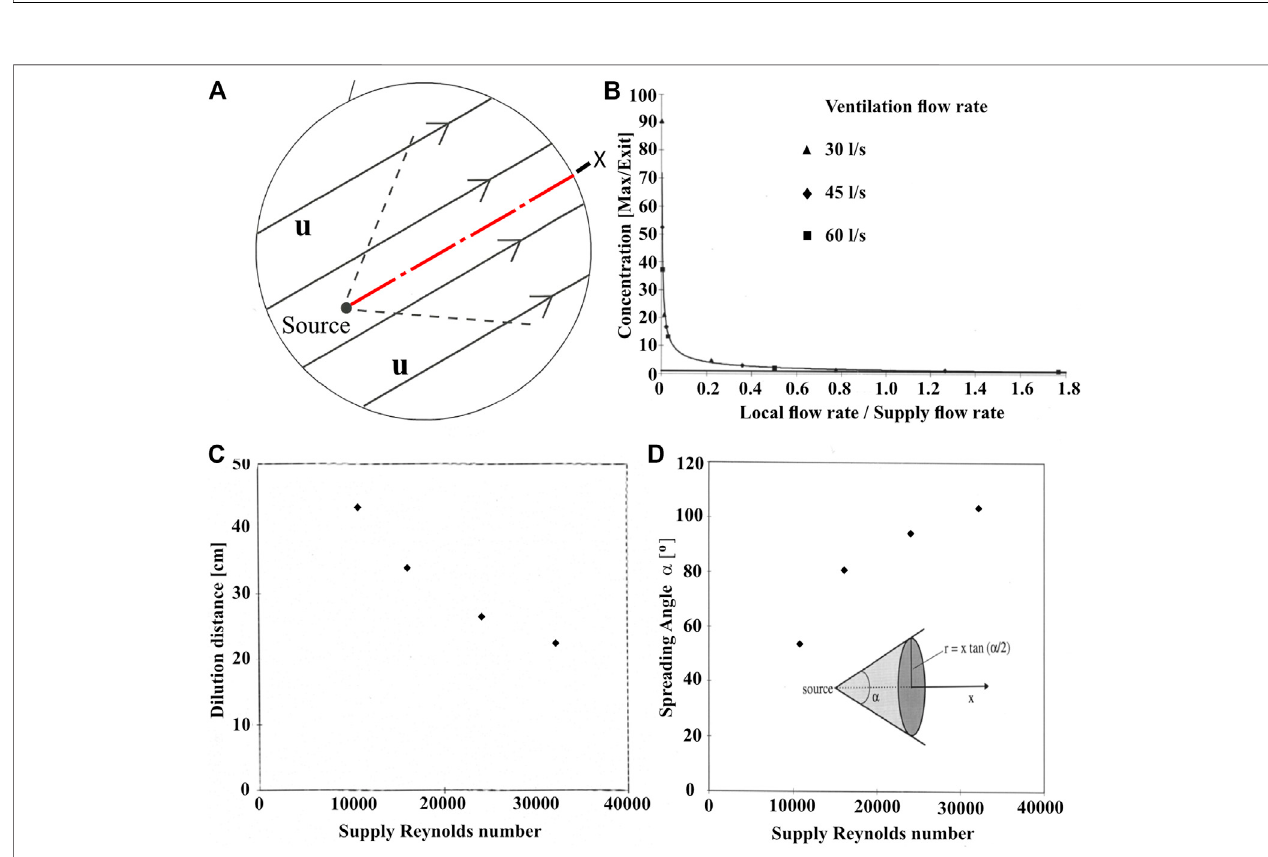
FIGURE 5 | Signature of the dilution of a point source; (A) Spreading cone. (B) Dilution. (C) Dilution distance. (D) Opening angle of the cone.